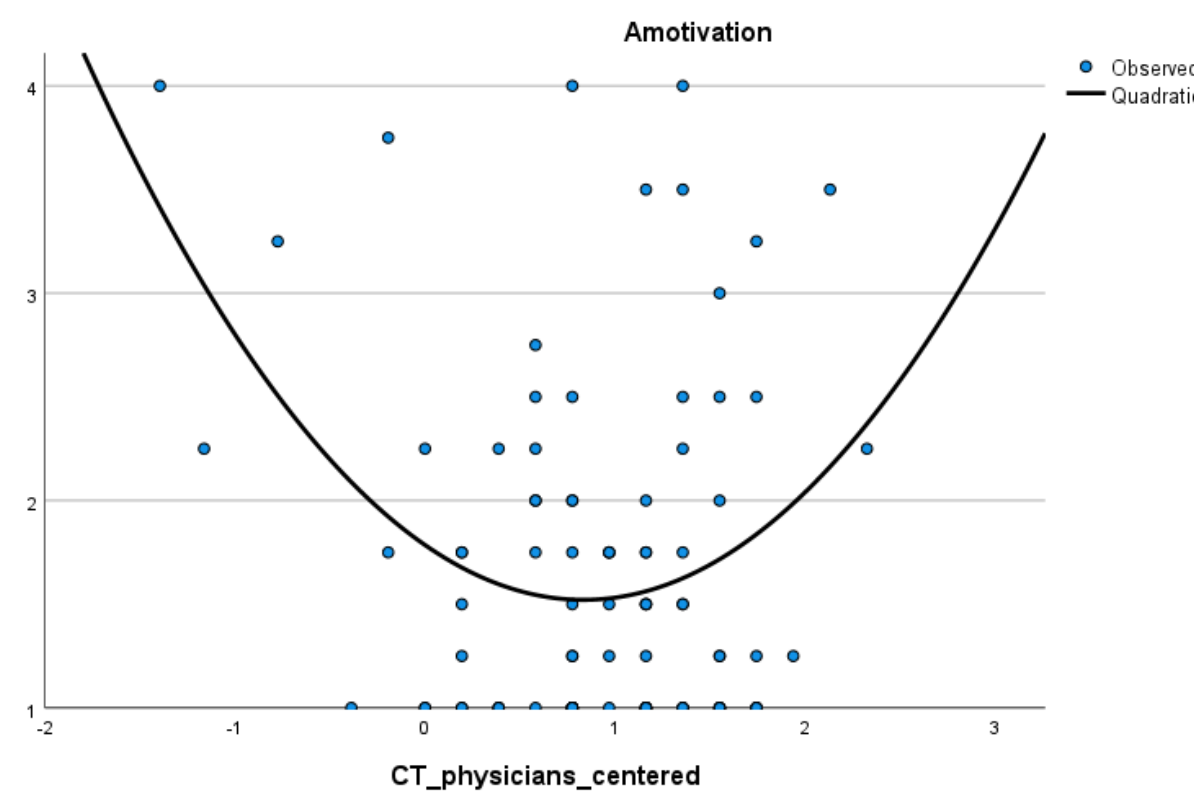
Figure 2. Graphical presentation of the quadratic association of clinical tribalism and amotivation. Note: CTE_physicians_centered represents clinical tribalism—a difference between nurses’ self-assessment and nurses’ perception of physicians’ infection prevention and control (IPC) competencies. CTE_physicians_centered is a centered variable (weighted through the scale mean value).